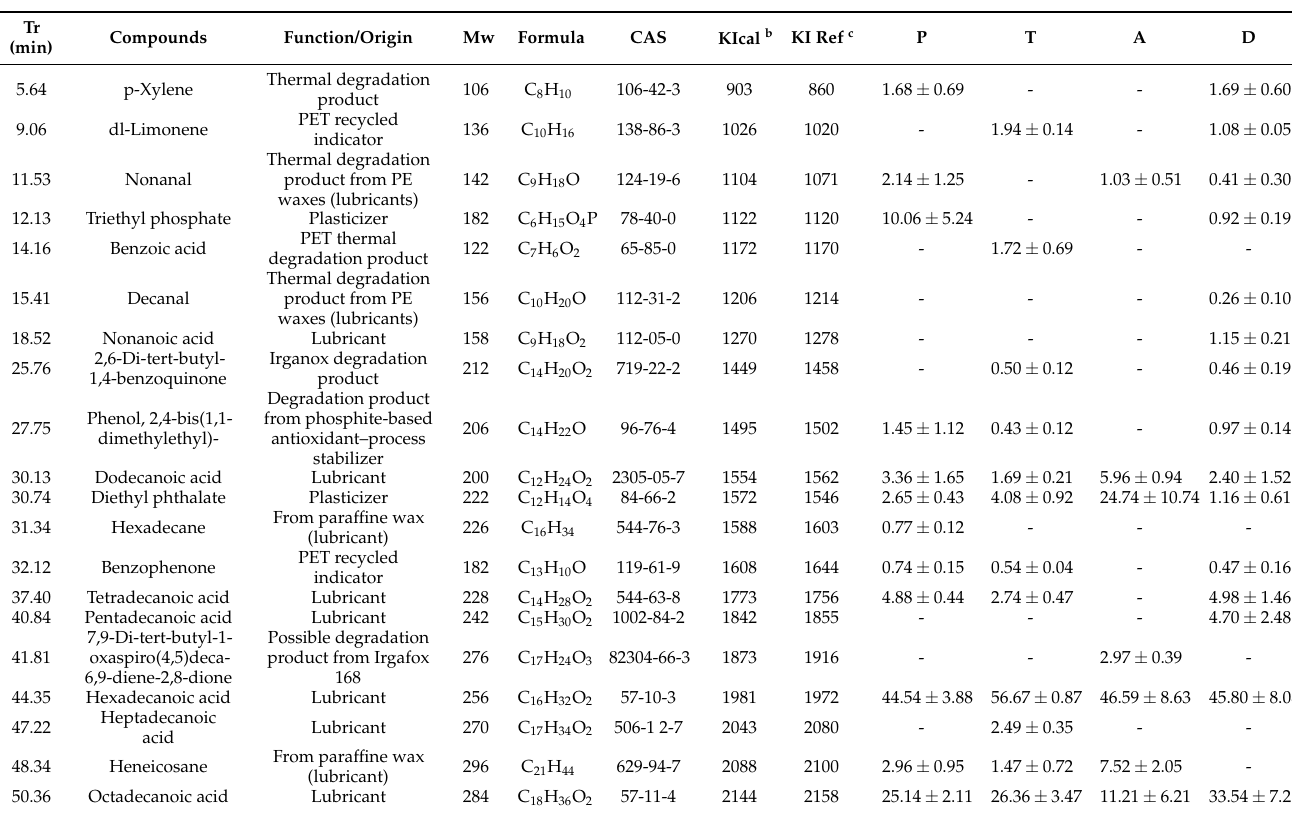
Table 2. GC-MS peak relative areas a of compounds identified in PET bottle samples.